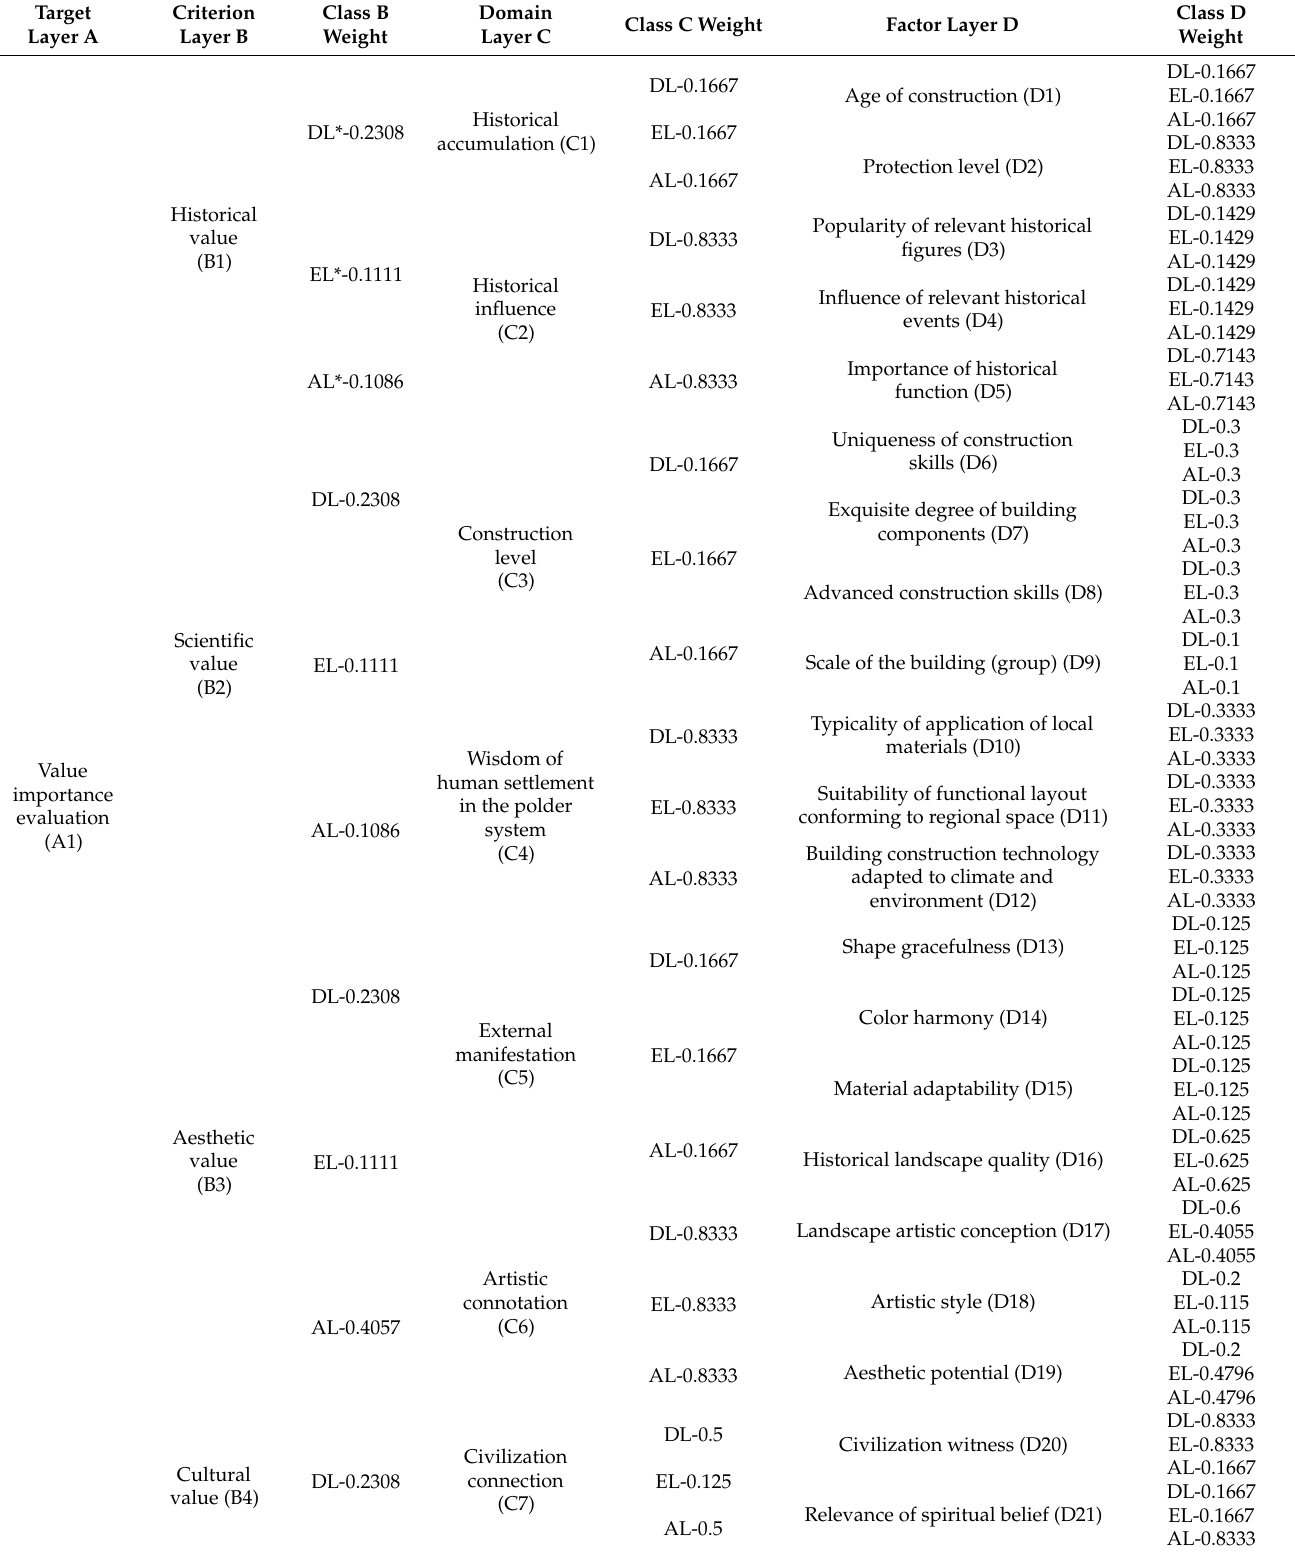
Table 5. Assessment scale of cultural landscape value importance in the demonstration